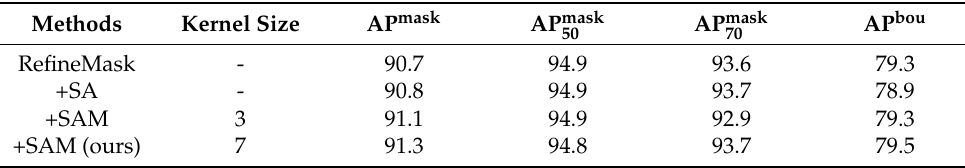
Table 6. Comparison with different kernel size of SAM and other